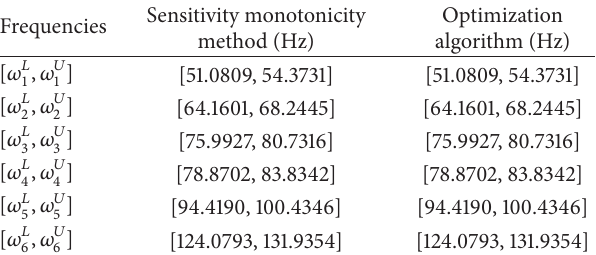
Figure 6: 12-element space frame structure.